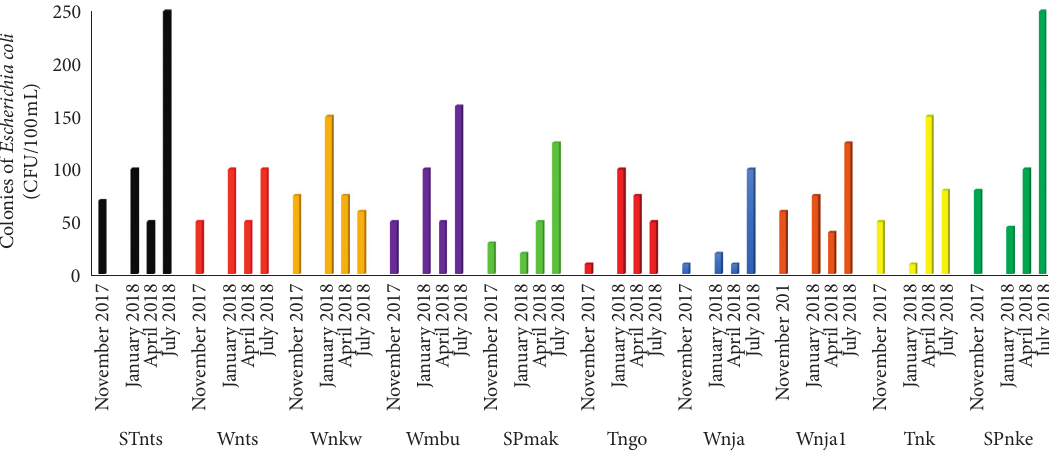
Figure 4: Colonies of Escherichia coli isolated in the sampled waters between November 2017 and July 2018.